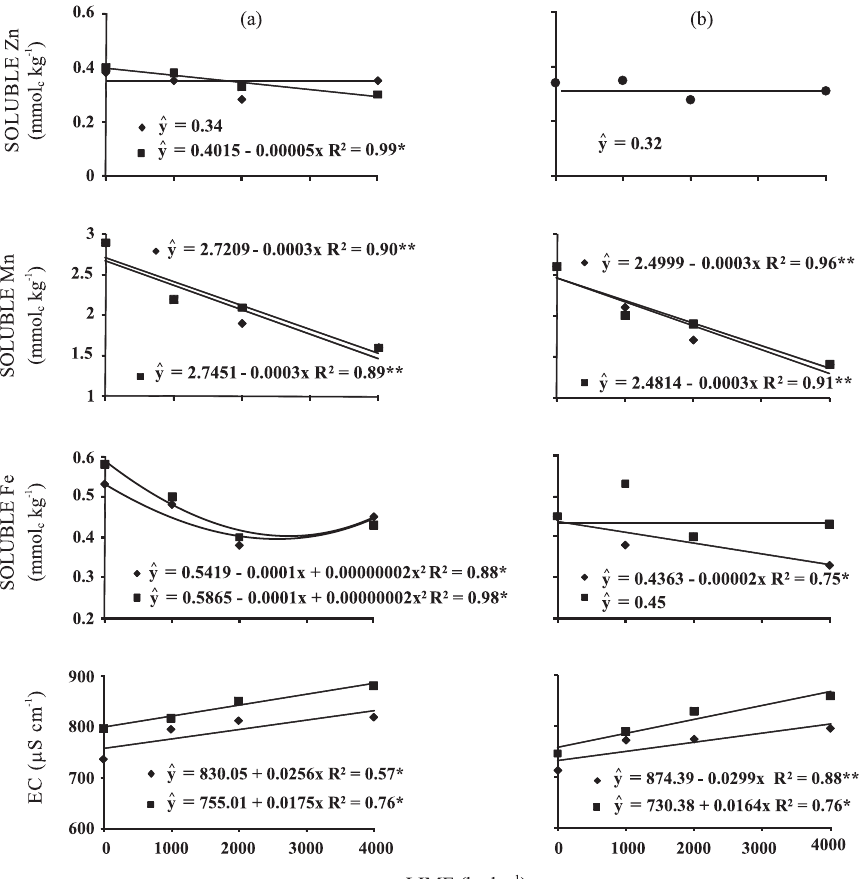
Figure 4. Contents of zinc, manganese, iron, and electrical conductivity (EC) in white oat at flowering, as related to surface liming. ( ) mean of the treatments with and without gypsum application, ( ) without gypsum and ( ) with gypsum in 2004/2005 (a) and 2005/2006 (b).